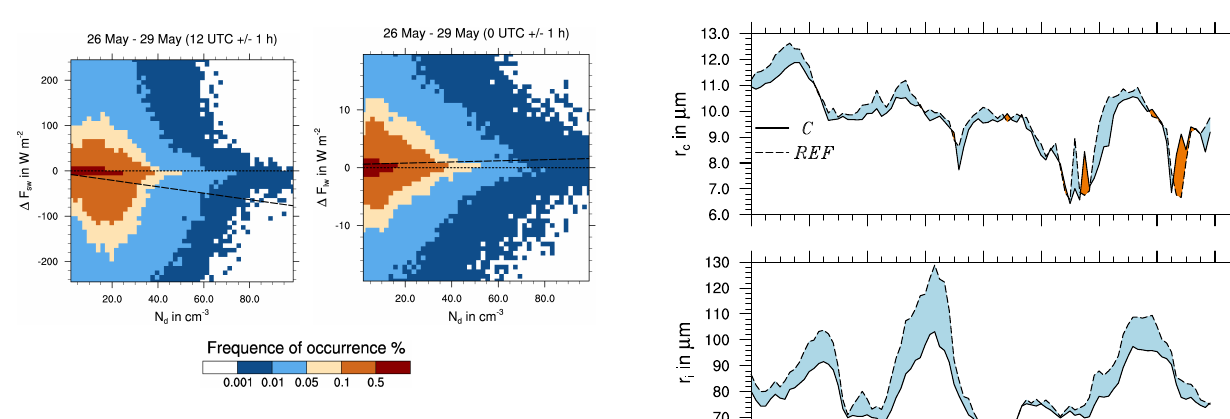
Fig. 11. Joint PDFs of differences (C minus REF) in surface net shortwave radiation flux around noon (left) and in surface net long- wave radiation flux around midnight (right) together with average dust concentration at grid points containing cloud ice (C). The dashed line is the result of a linear regression fit of the data.